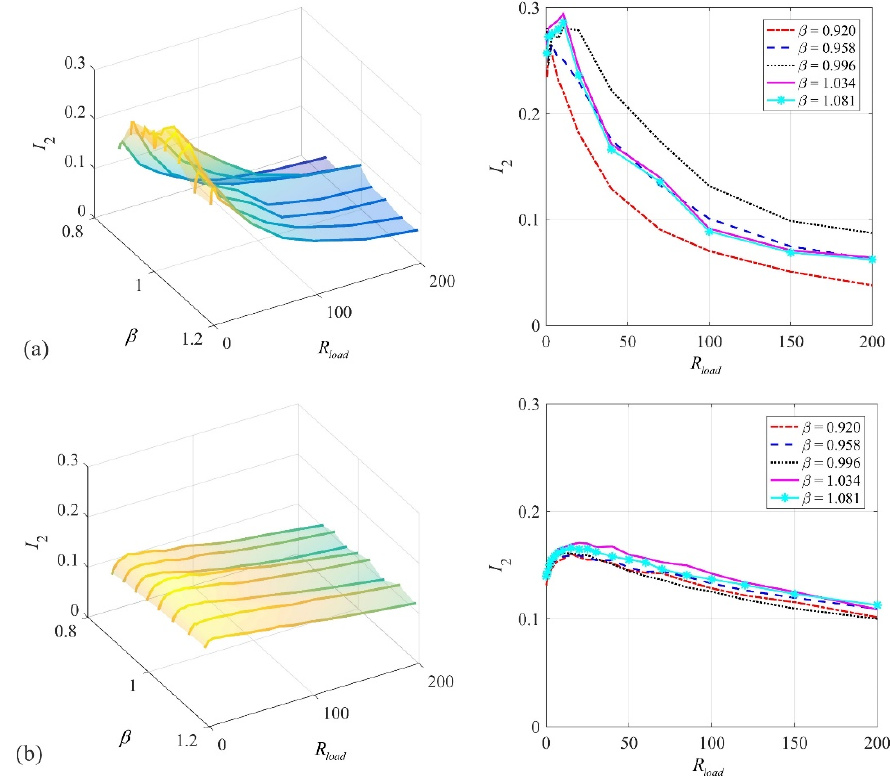
Figure 18. 3D and 2D plots of I 2 with µ = 0.154: ( a ) experimental result; ( b ) simulation result.